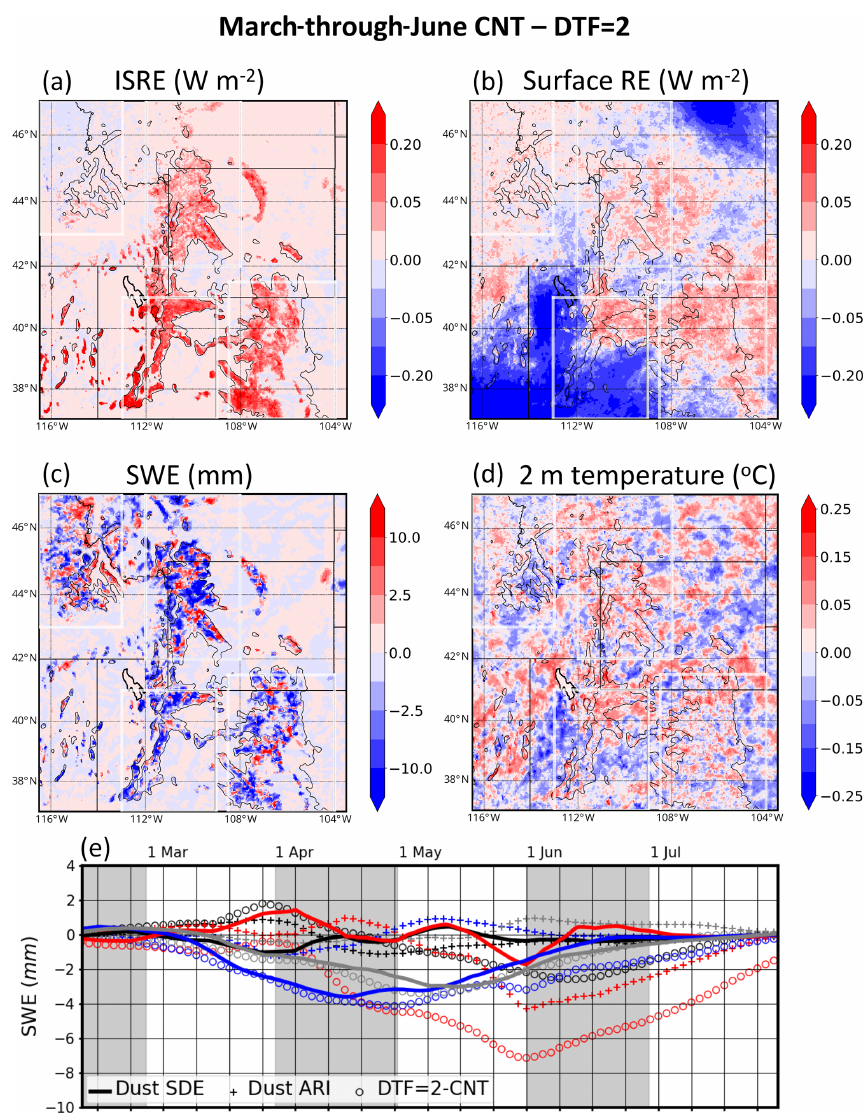
Figure 13. DTF = 2 – CNT March-through-June-averaged (a) ISRE, (b) surface RE, (c) SWE, and (d) 2m temperature. Panel (e) shows low-pass-filtered time series of dust SDE from CNT (solid lines), dust ARI from CNT (crosses), and perturbations to SWE brought forth by increasing the DTF to 2 (DTF = 2 – CNT; hollow circles). Colors indicate the subregions, as in previous figures: Greater Idaho (black), Northern Rockies (red), Utah Mountains (blue), and Southern Rockies